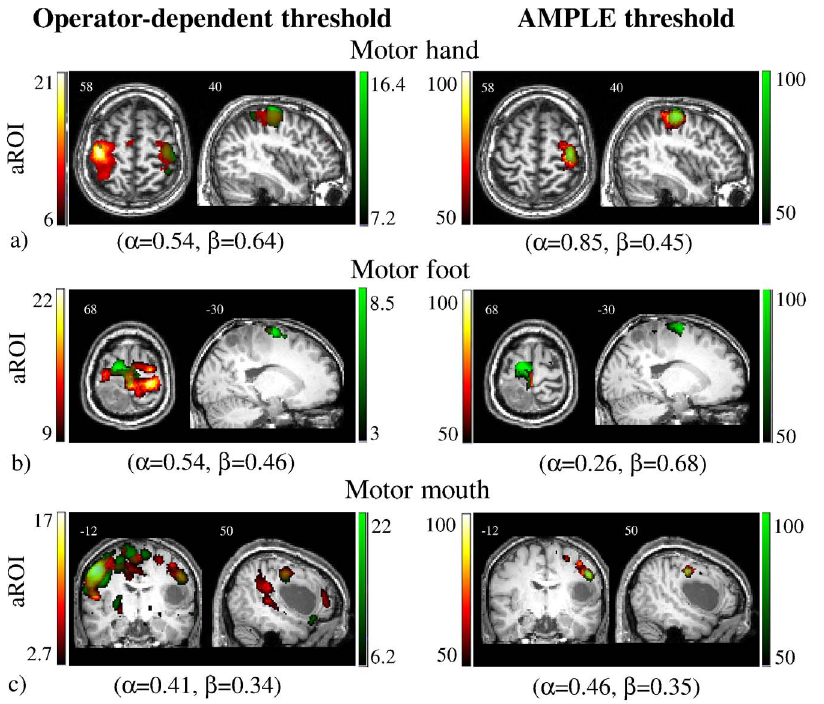
Figure 4. Example of direct comparison between the thresholds chosen by two operators and the thresholds determined by AMPLE. Concordance between task-based (tb-fMRI, in green) and resting-state (rs-fMRI, in red) fMRI maps computed with aROI. Overlap sensitivity ( a ) and specificity ( b ) of rs-fMRI with respect to tb-fMRI are reported. a) For case 1 mapping of the hand area with AMPLE was satisfactory and aROI sensitivity increased with respect to the operator-dependent threshold. b) For case 9 mapping of the foot area with AMPLE was good with tb-fMRI, while with aROI the paracentral lobule was not activated and aROI sensitivity decreased with respect to the operator-dependent threshold. c) In case 8 mapping of the mouth area with AMPLE was successful with both tb-fMRI and rs-fMRI and results were similar to those obtained with the operator- dependent threshold. Images are shown in neurological convention (left is left) and MNI coordinates are reported on top of each slice.